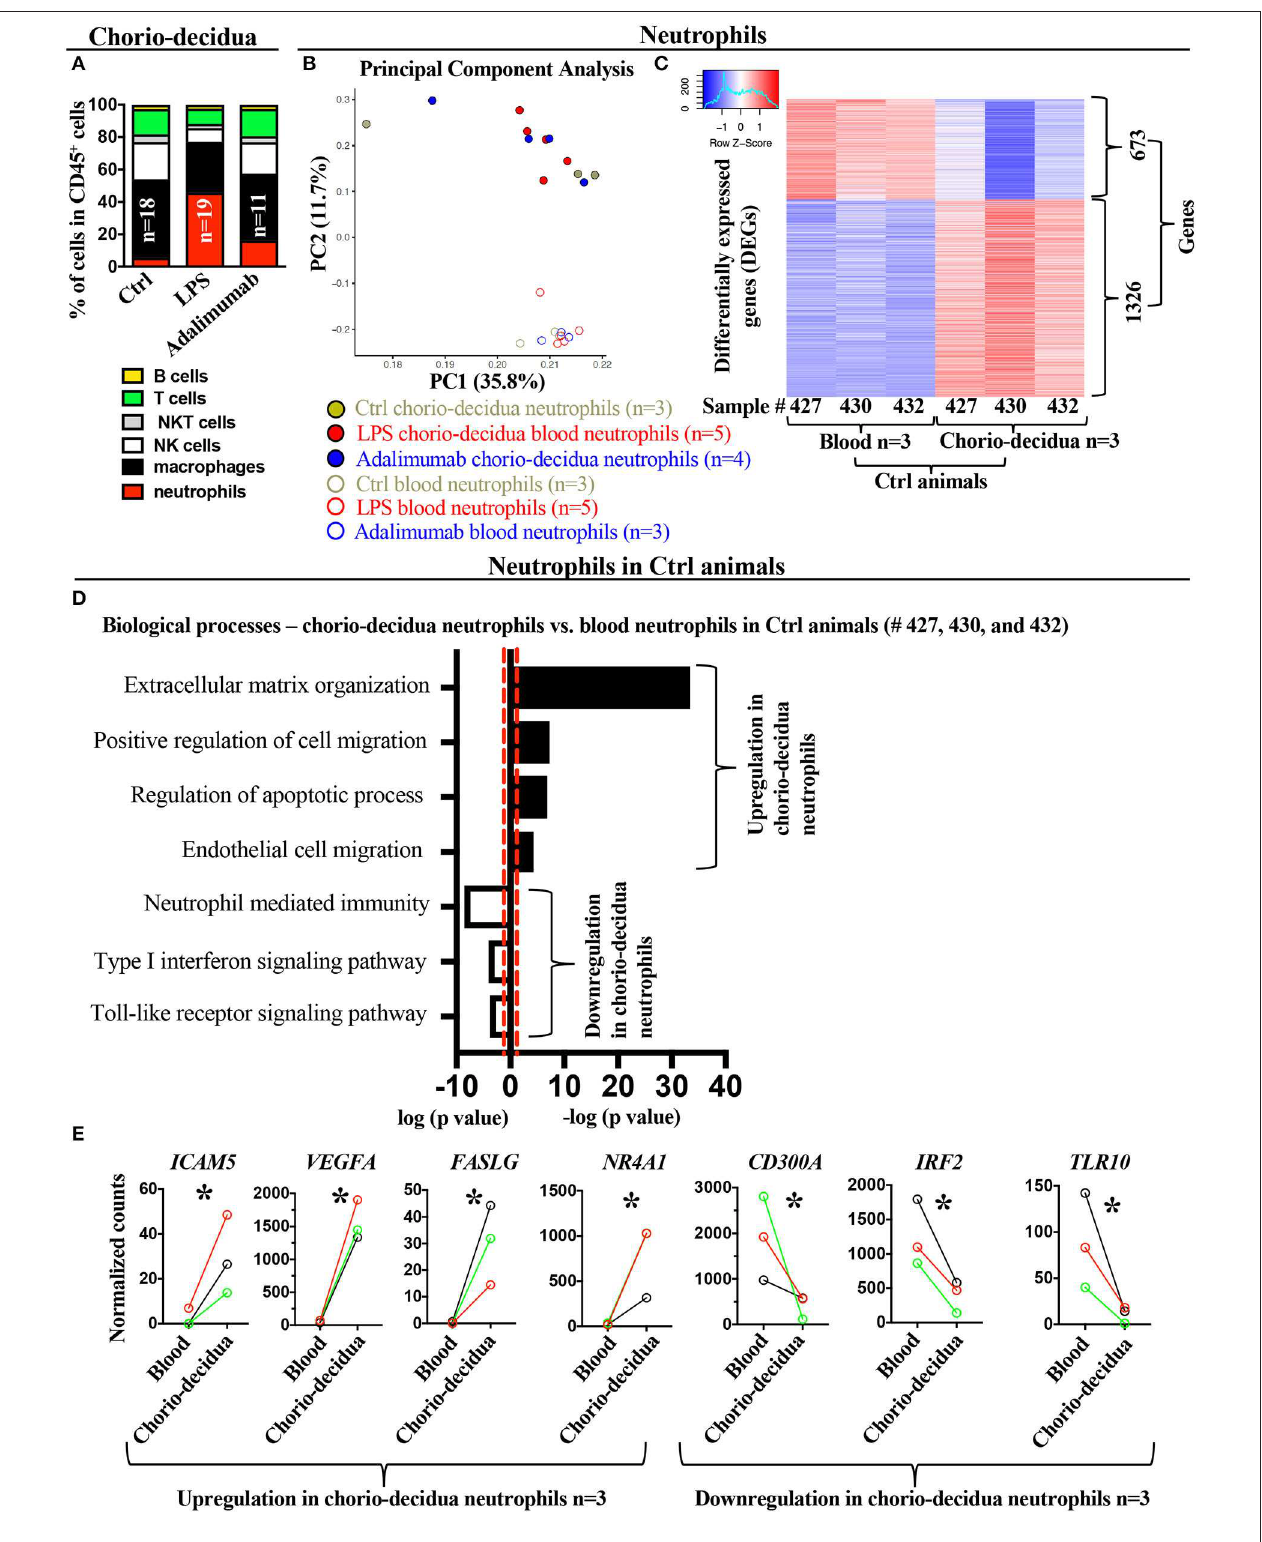
FIGURE 1 | Changes in the global transcriptional landscape of chorio-decidua neutrophils compared to blood neutrophils. (A) Chorio-decidua cells were scraped, digested with protease/DNAase and single cell suspensions were used for multiparameter flow cytometry phenotyping. CD45 + subsets showed a neutrophil